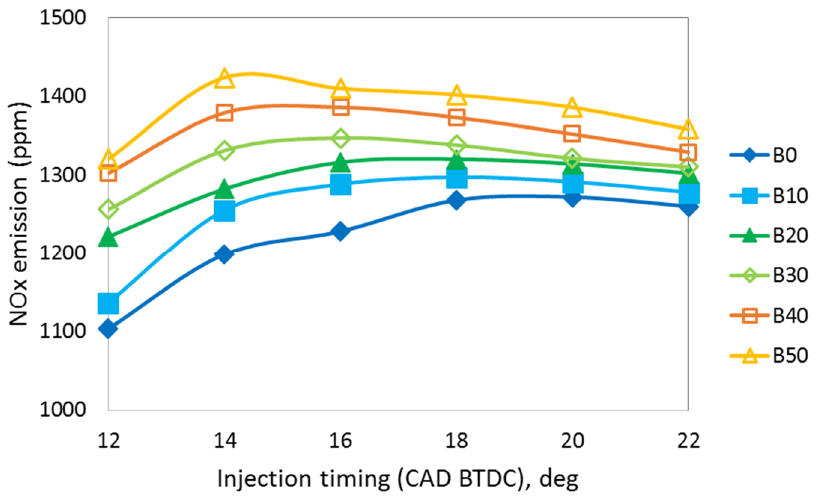
Figure 17. Effect of injection timing on engine NOx emission.